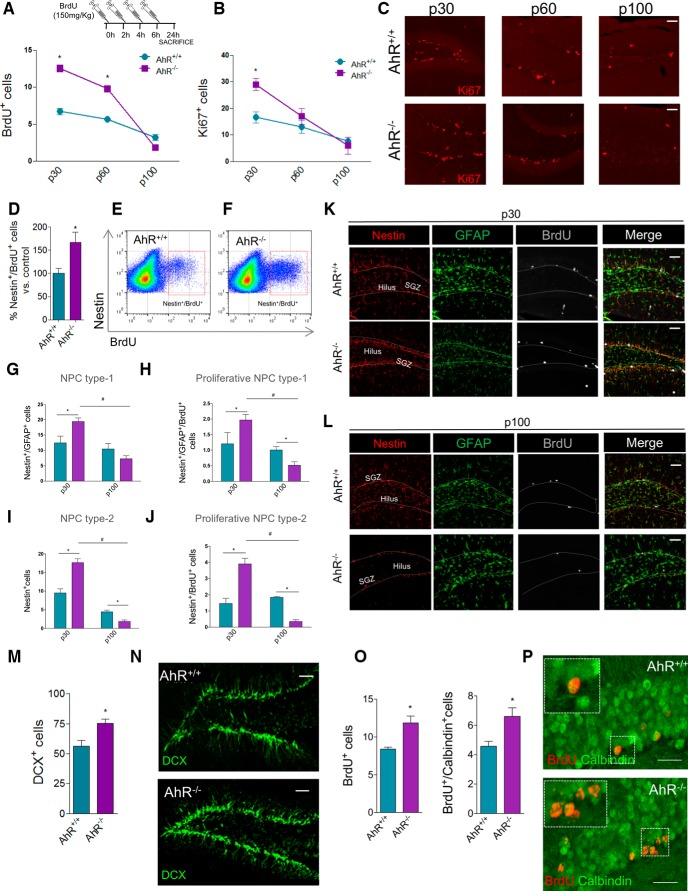
The absence of AhR exacerbates adult hippocampal neurogenesis. A, BrdU+ cells in the DG of AhR+/+ and AhR–/– mice measured at p30, p60, and p100 24 h after the last BrdU injection. Two-way ANOVA demonstrated a significant interaction between the age and genotype [F(2, 24) = 9.51; p < 0.05; *, p < 0.05 vs. AhR+/+; n = 5 animals/group]. B, C, Ki67+ cells in the DG of AhR+/+ and AhR–/– mice measured at p30, p60, and p100. Two-way ANOVA demonstrated a significant interaction between the age and genotype [F(2, 28) = 8.56; p < 0.05; *, p < 0.05 vs. AhR+/+; n = 5–6 animals/group]. Representative images of Ki67+ cells in AhR+/+ and AhR–/– mice at different time points are shown in C. D–F, Quantification of the number of nestin/BrdU+ cells by flow cytometry 24 h after BrdU administration. Data are expressed as the percentage of control group (*, p < 0.05 vs. AhR+/+; n = 6 animals/group; D). Representative dot plots of double-stained cells for nestin and BrdU in the DG of AhR+/+ (E) and AhR–/– (F) mice. G–L, Characterization of type-1 (nestin+/GFAP+; G) and type-2 progenitors (nestin+/GFAP-; I) and their proliferative capacity (BrdU+; H and J) in the DG of AhR+/+ and AhR–/– mice determined at p30 and p100. Representative images of nestin (red), GFAP (green), BrdU (gray) of DG of AhR+/+ and AhR–/– mice at p30 (K) and p100 (L; *, p < 0.05 vs. AhR+/+; #, p < 0.05 vs. AhR–/–; n = 4–6 animals/group). M, N, Quantification of the number of DCX+ cells in the DG of WT and AhR–/– mice (*, p < 0.05 vs. AhR+/+; n = 7–8 animals/group). Representative images of DCX+ cells in AhR+/+ and AhR–/– mice are shown in N. O, P, Quantification of the number of BrdU+ cells (left) and newborn integrated neurons (BrdU+/Calbindin+; right) determined 28 days after BrdU administration (*, p < 0.05 vs. AhR+/+; n = 7–9 animals/group). Representative colocalization images for BrdU and calbindin in AhR+/+and AhR–/– mice are shown in P. Insets display high-magnification images. Numbers of cells are expressed per 1000 μm2. Data are mean ± SEM. Scale bar is 50 μm in C, J, K, and L; 70 μm in N; and 30 μm in P. Data were compared by using nonparametric 2-tailed Mann–Whitney test in D, M, and O or nonparametric 2-way ANOVA followed by Bonferroni post hoc testing (A, B, G–J).